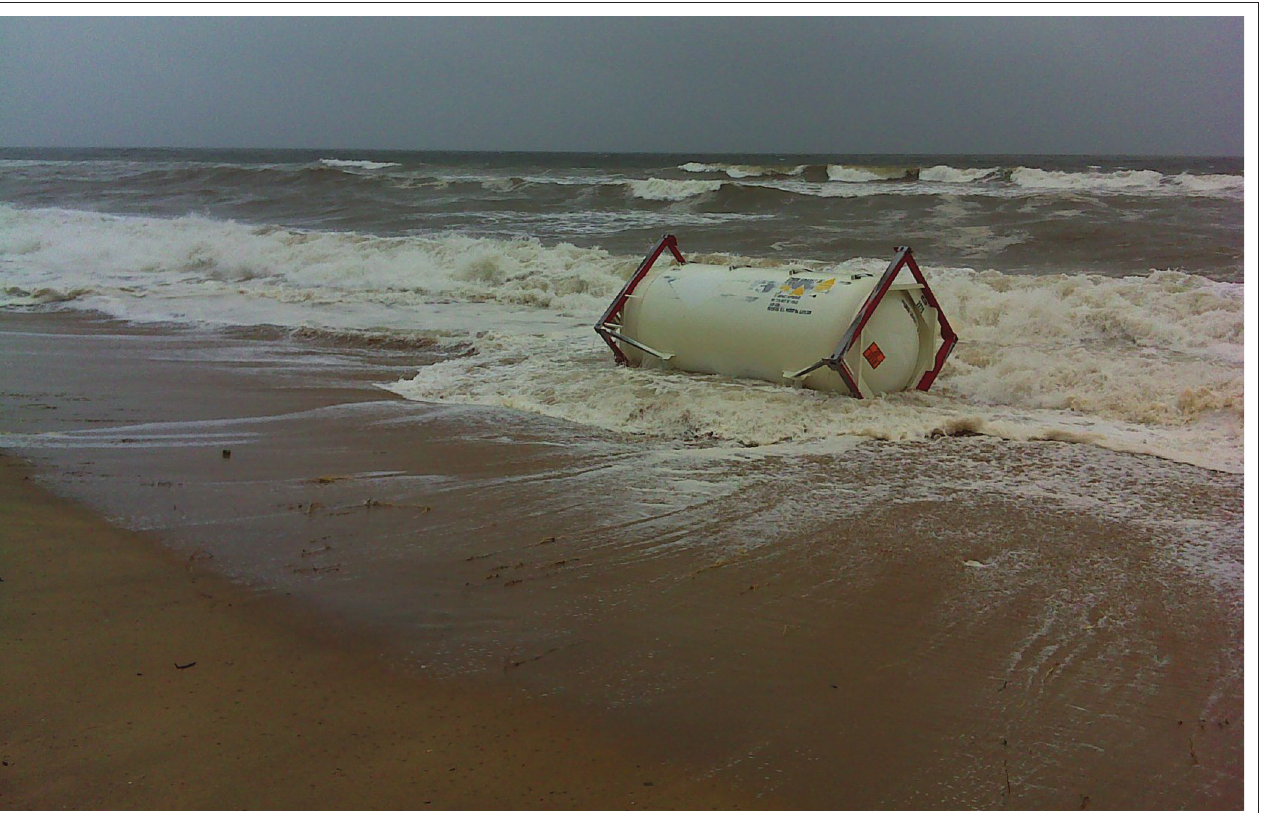
Source : Photograph taken by Faisel T. Illiyas FIGURE 5: Container at Mogral beach moving by the wave